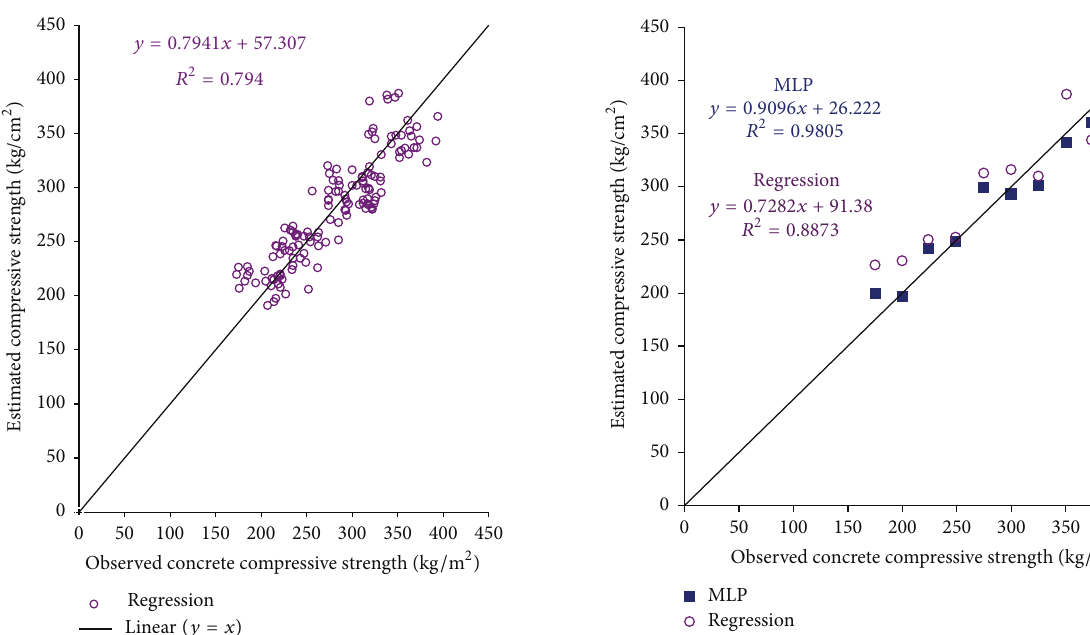
Figure5:Comparisonofobservedcompressivestrengthofconcrete that calculated one with regression model.